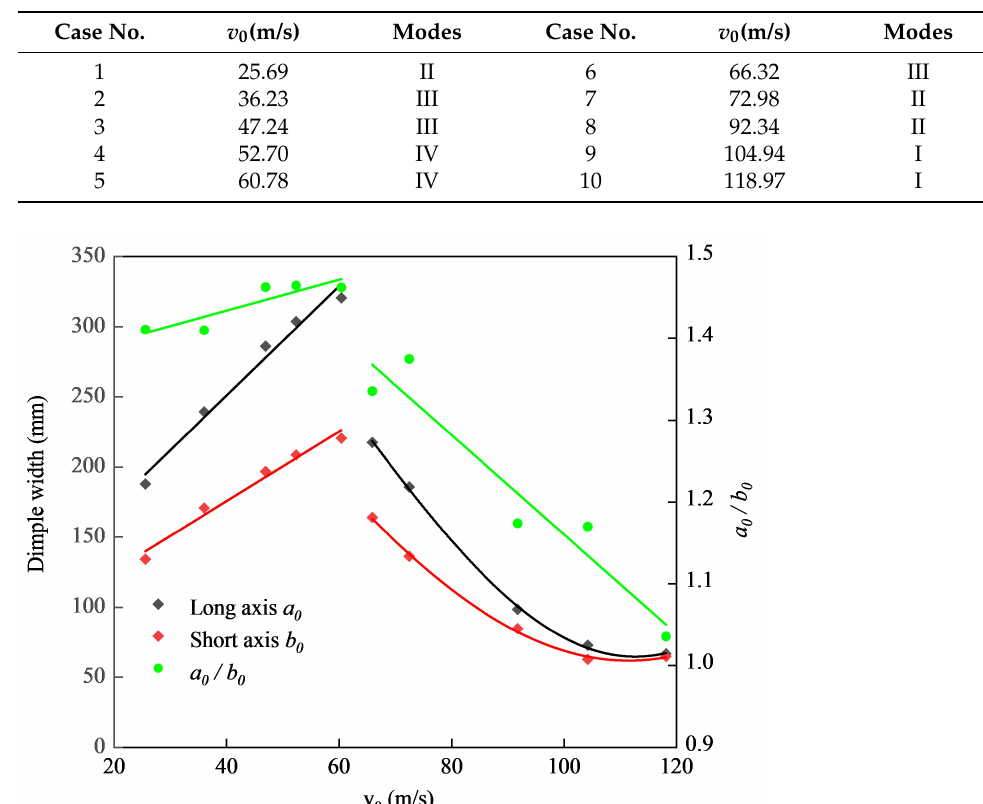
Table 2. Deformation modes of impacted ellipsoidal shells.